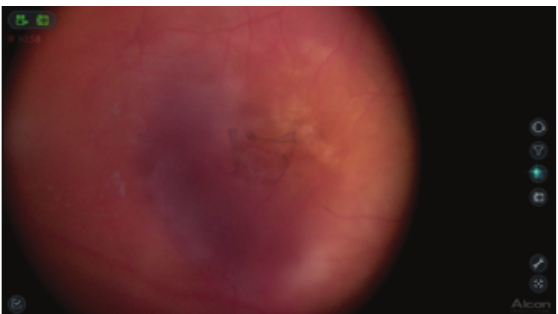
Figure 2. Intraoperative snapshot showing fs-ILM peeling using 3-D surgical viewing and I-OCT. The I-OCT shows no evidence of any iatrogenic complication.